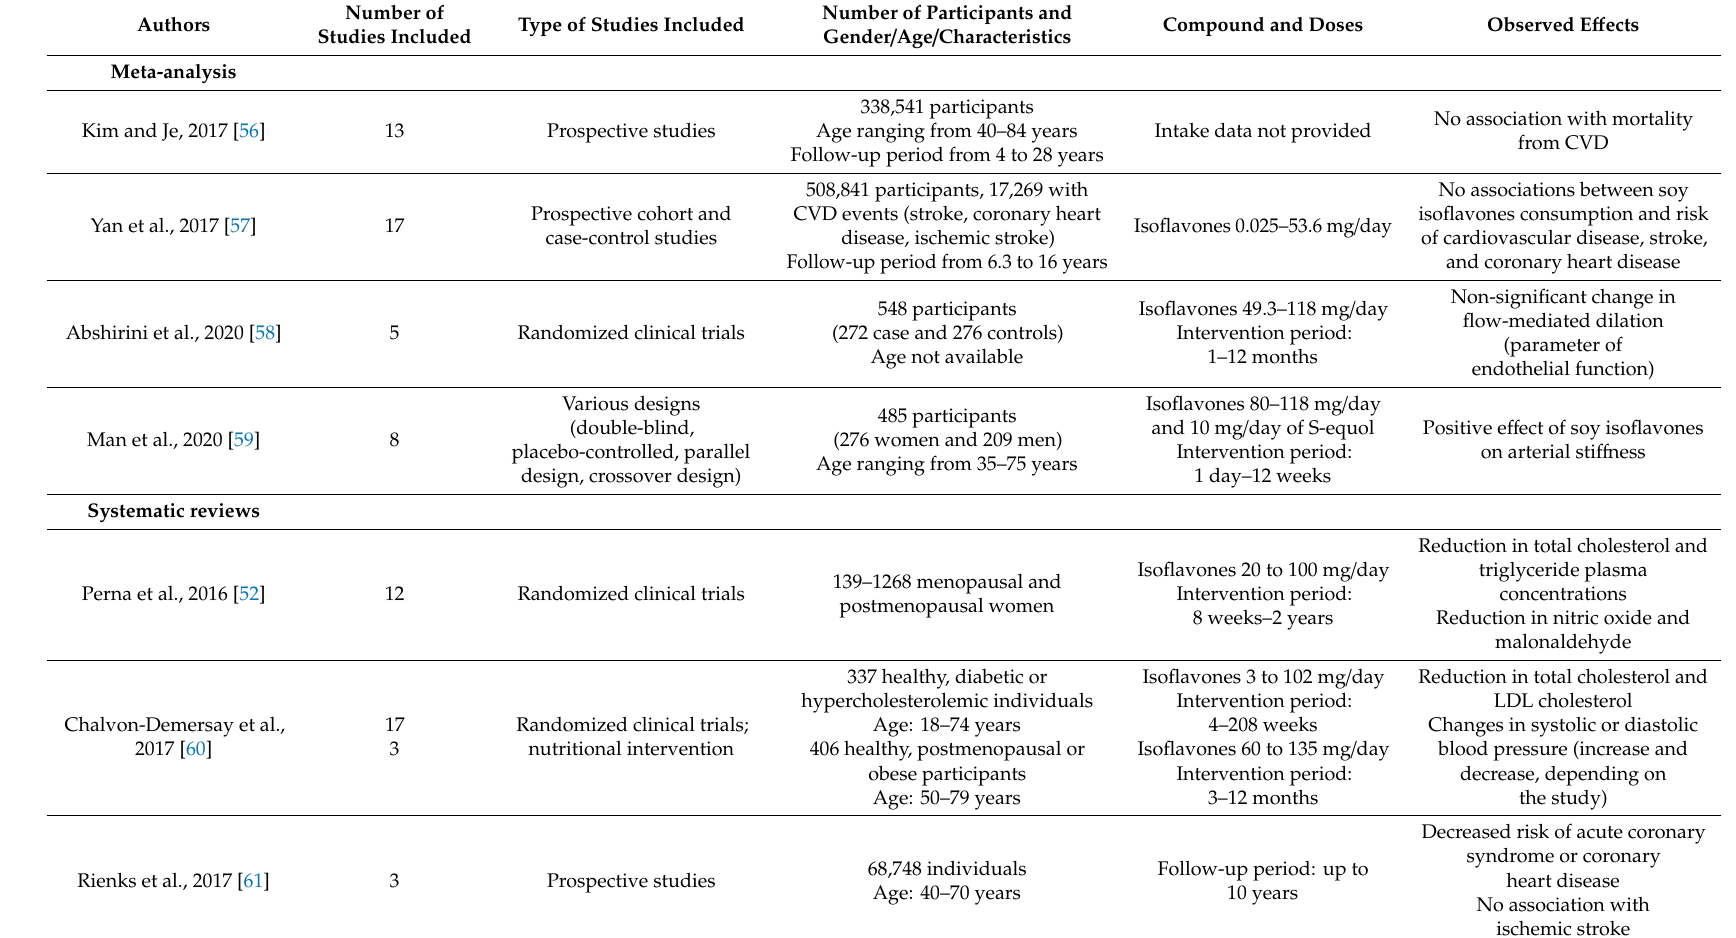
Table 3. E ff ects of isoflavones in cardiovascular disease-related